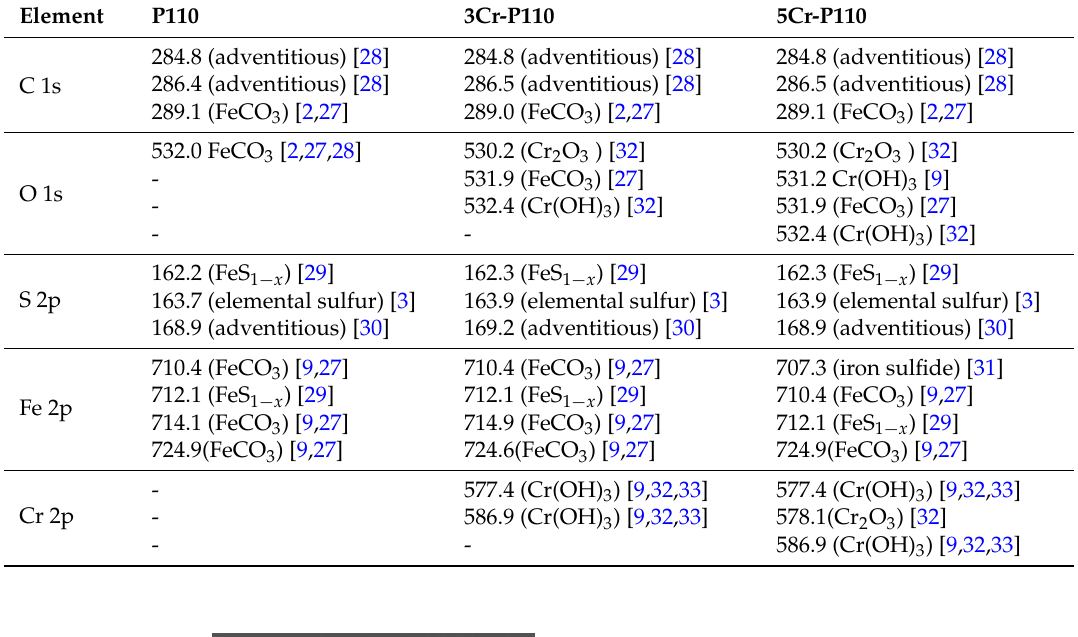
Table 2. Binding energies of Fe 2p, O 1s, S 2p, and Cr 2p for inner scales on P110, 3Cr-P110, and 5Cr-P110 samples exposed to 3.5 wt % NaCl solution with CO 2 and H 2 S ( P CO 90 ˝ C, 1 m/s, 360 h). All binding energies are accurate to within ˘ 0.2 eV or less based on three measurements per sample.